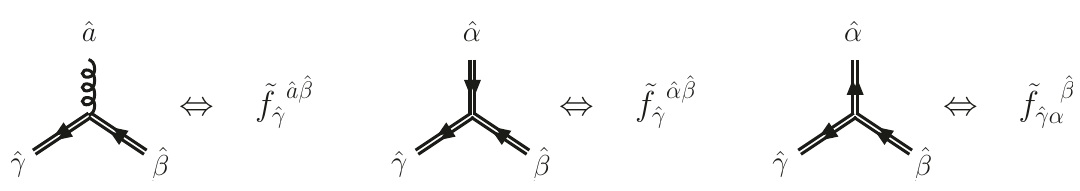
Figure 3 . Additional types of cubic interactions that are obtained after the gauge symmetry is spontaneously-broken in a purely adjoint theory. The resulting amplitudes are organized around cubic graphs where these vertices are included. The corresponding color factors are contractions of the various types of structure